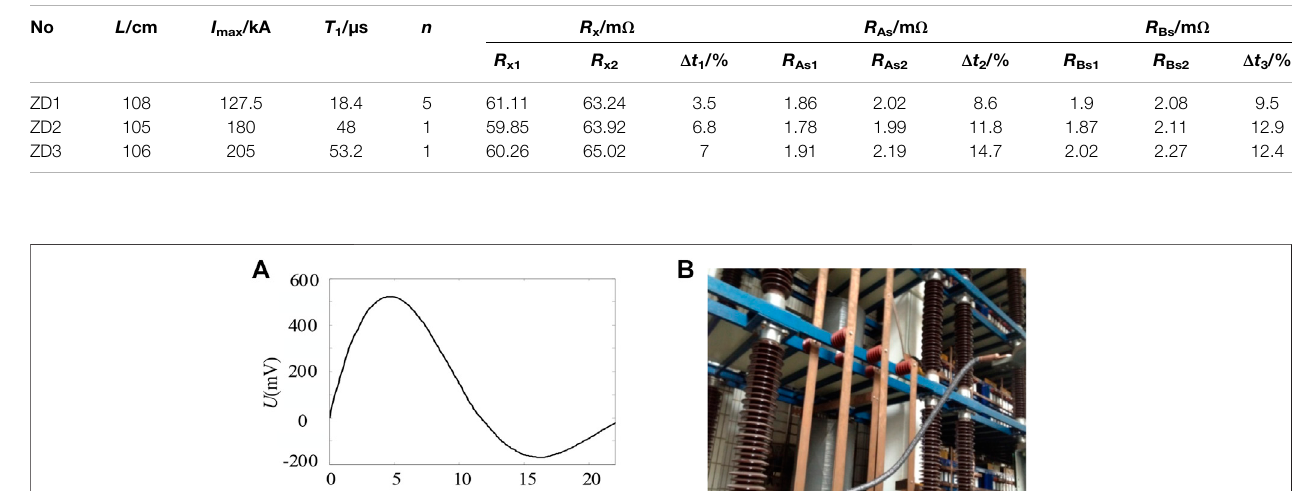
TABLE 3 | Measured resistance values of impulse withstand test with standard lightning current waveform.